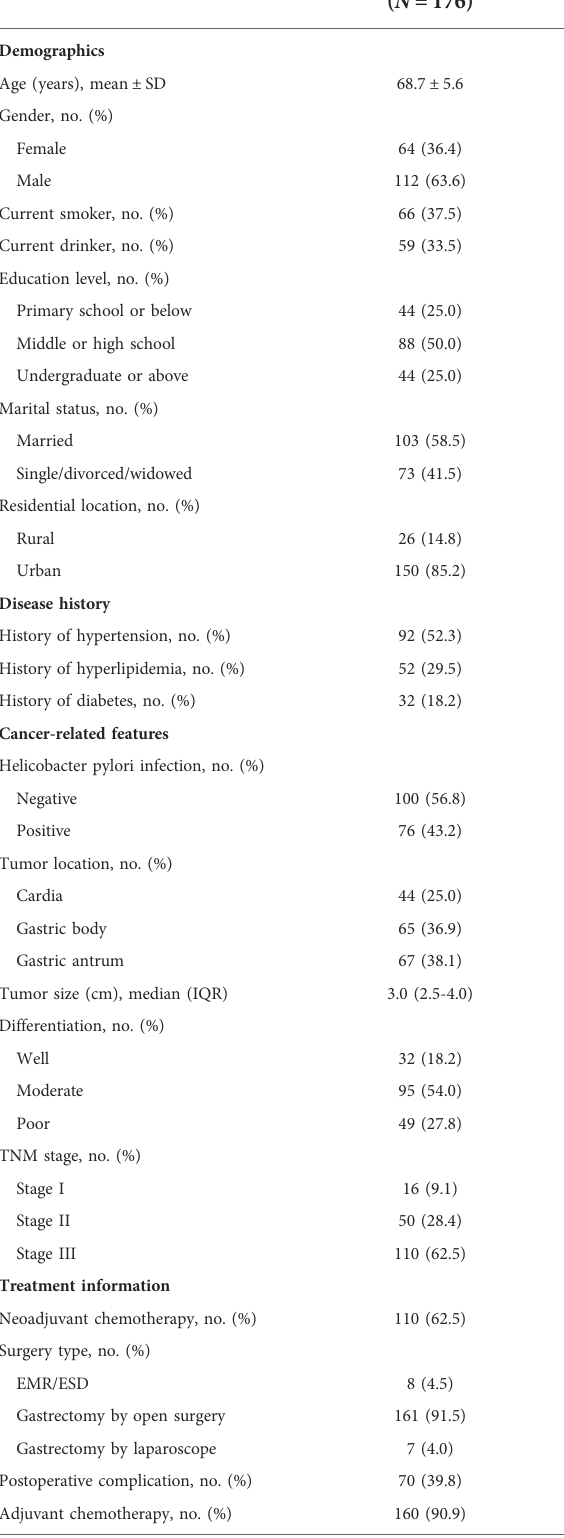
TABLE 1 Clinical